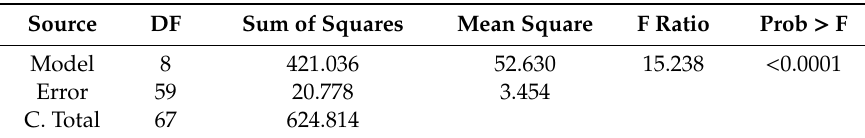
Table 8. ANOVA table of the model used.